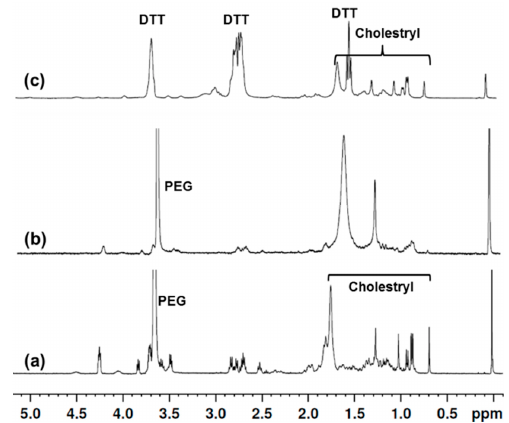
Figure 4. ( a ) 1 H NMR spectra of poly(ethylene glycol)-cholesteryl conjugate (Chol-ss-PEG-ss-Chol) measured in CDCl 3 ; and ( b ) lyophilized sample after DL -dithiothreitol (DTT) treatment; ( c ) Mixture extracted with diethyl ether after DTT treatment.